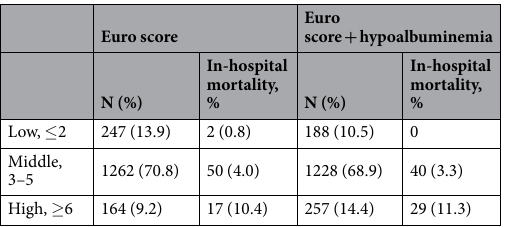
Table 3. Risk of in-hospital death stratified by different Euro scores.